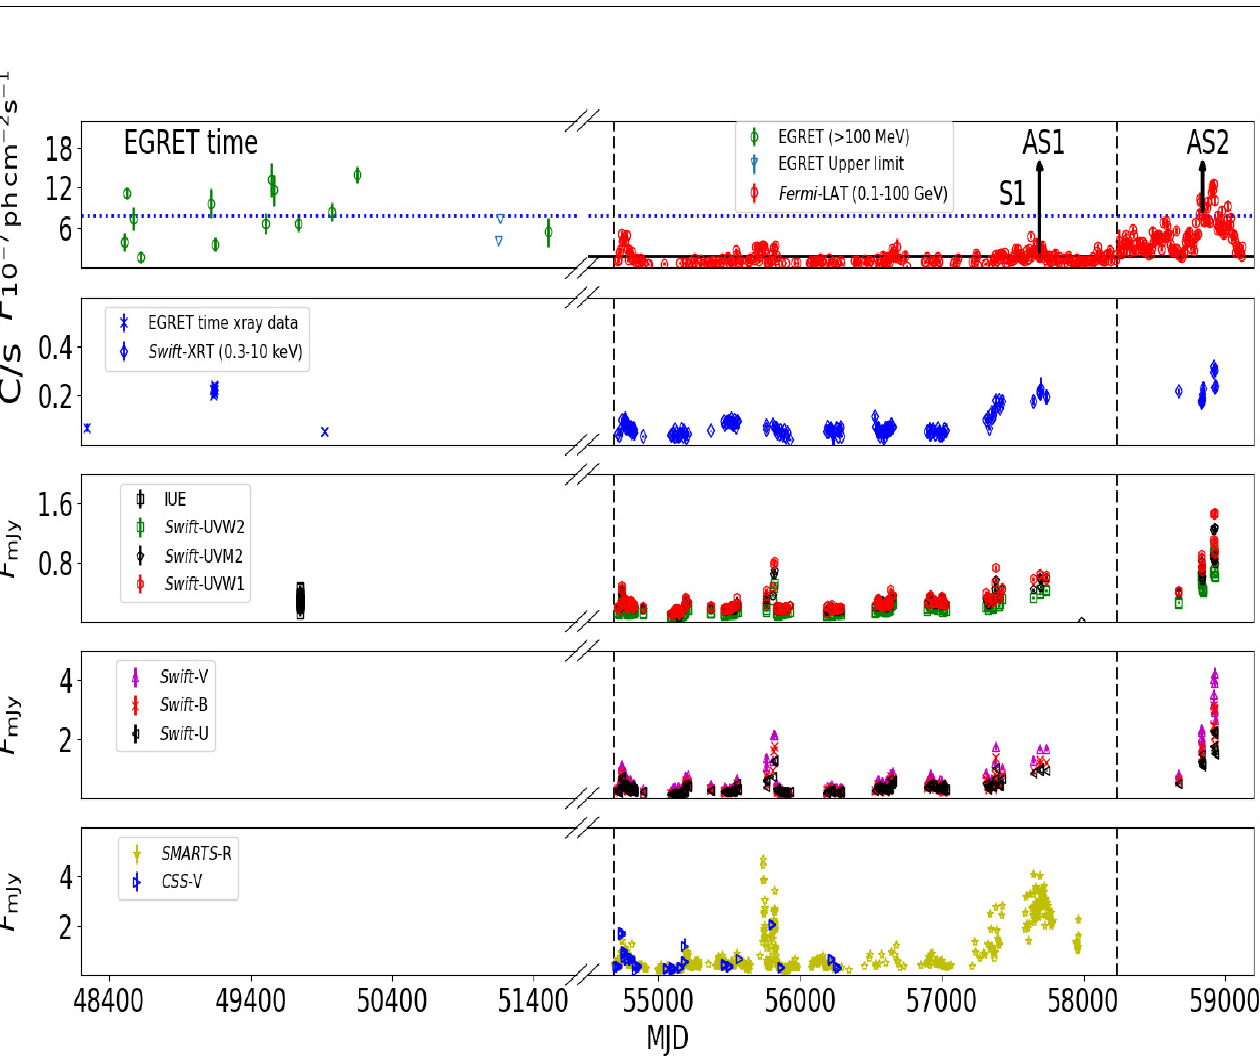
Figure 1. Multi-band lightcurve of PKS 0208-512. The γ -ray data before the broken axis is from Stacy et al. [50]. The references of the X-ray data during the EGRET time are given in Table 1. The UV data during the EGRET time is taken from Stacy et al. [45]. The other multi-band data descriptions are as follows: variation of 0.1–100 GeV γ -ray flux from Fermi -LAT in weekly bins, X-ray flux: Swift -XRT data products generator, UV/optical data: Swift -UVOT, SMARTS and CRTS . The dotted blue and solid black horizontal lines represents the EGRET and Fermi -LAT average γ -ray flux, respectively. The black dashed vertical lines separate the activity states of the source in γ -ray